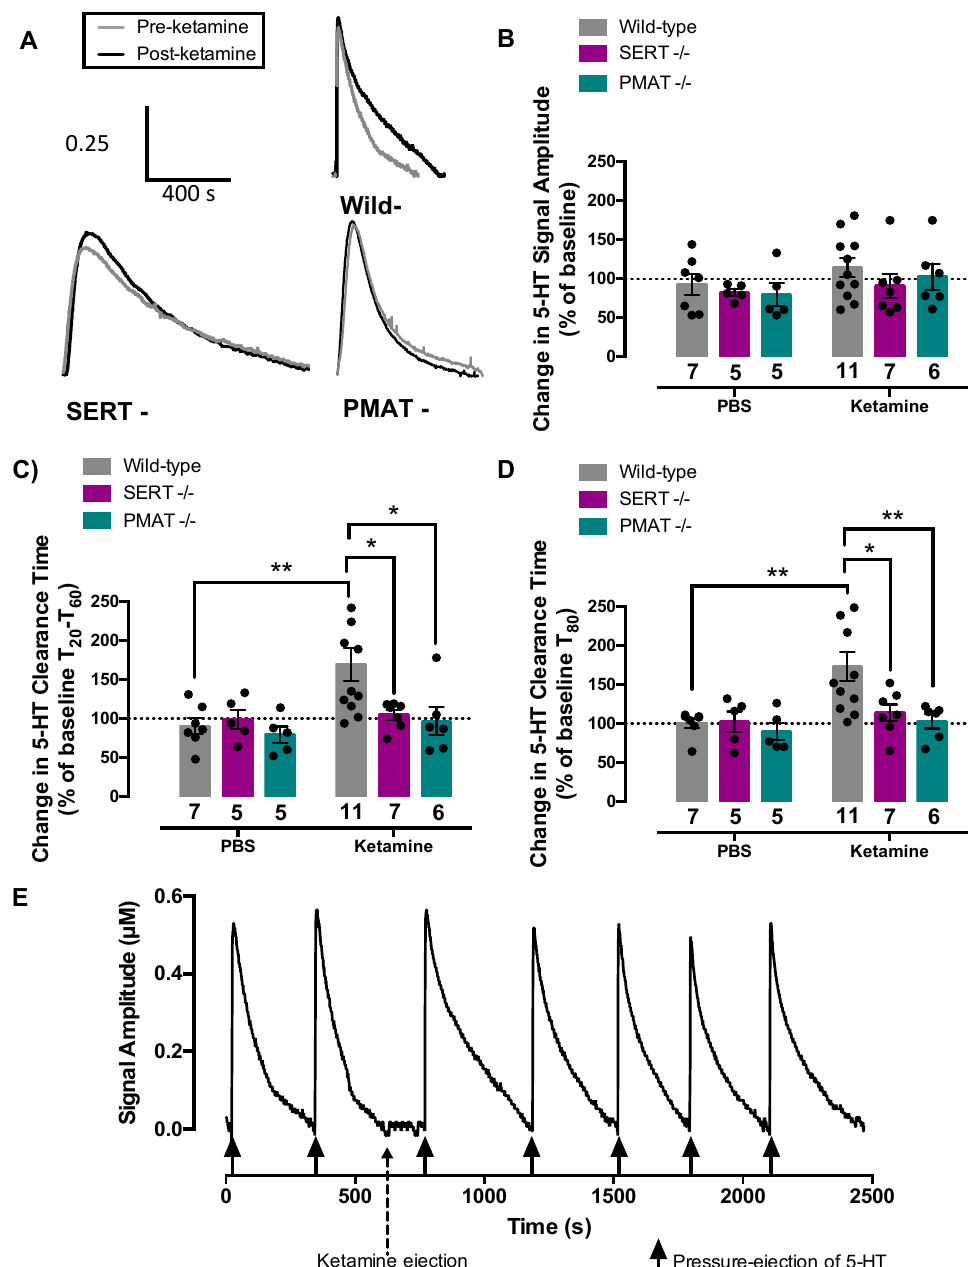
Figure 4. Ketamine significantly inhibited serotonin clearance in wild-type mice, but not in mice lacking SERT or PMAT. ( A ) Representative oxidation currents produced by pressure-ejecting serotonin into CA3 region of hippocampus before (grey) and after (black) local application of ketamine. Traces are superimposed for ease of comparison. ( B ) Percent change in serotonin signal amplitude did not differ between treatments and across genotypes. Percent change in serotonin clearance time ( C ) T 20 -T 60 , and ( D ) T 80 increased in wild-type mice, but was unchanged in SERT − / − and PMAT − / − mice. ( E ) Representative time course for serotonin clearance in a wild-type mouse following ketamine ejection. Note that pressure-ejection of ketamine did not perturb baseline oxidation current, indicating that ketamine did not evoke detectable release of endogenous serotonin. * p < 0.05 ** p < 0.01. Circles represent individual mice. Data are mean ± S.E.M.